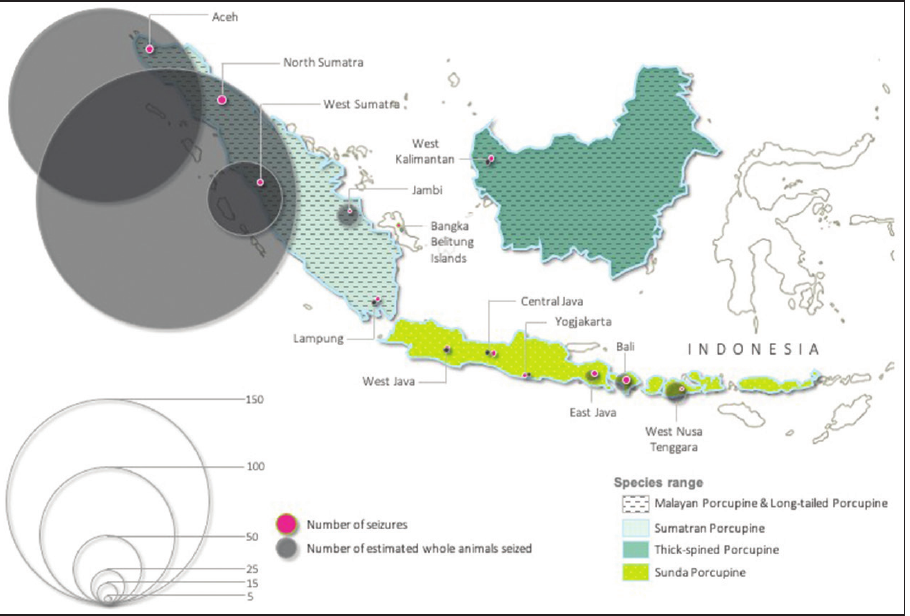
Figure 2. Location of porcupine seizure incidents by provinces in Indonesia including number of sei- zures at each location and estimated whole porcupines involved from January 2013 to June 2020; as well as the range of the five porcupine species that occur in Indonesia based on data extracted from the IUCN Red List of Threatened